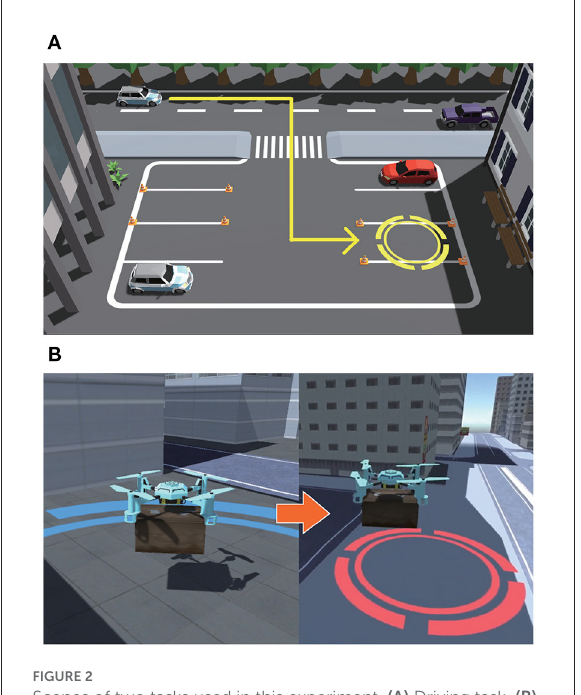
FIGURE2 Scenes of two tasks used in this experiment. (A) Driving task. (B) Drone task.